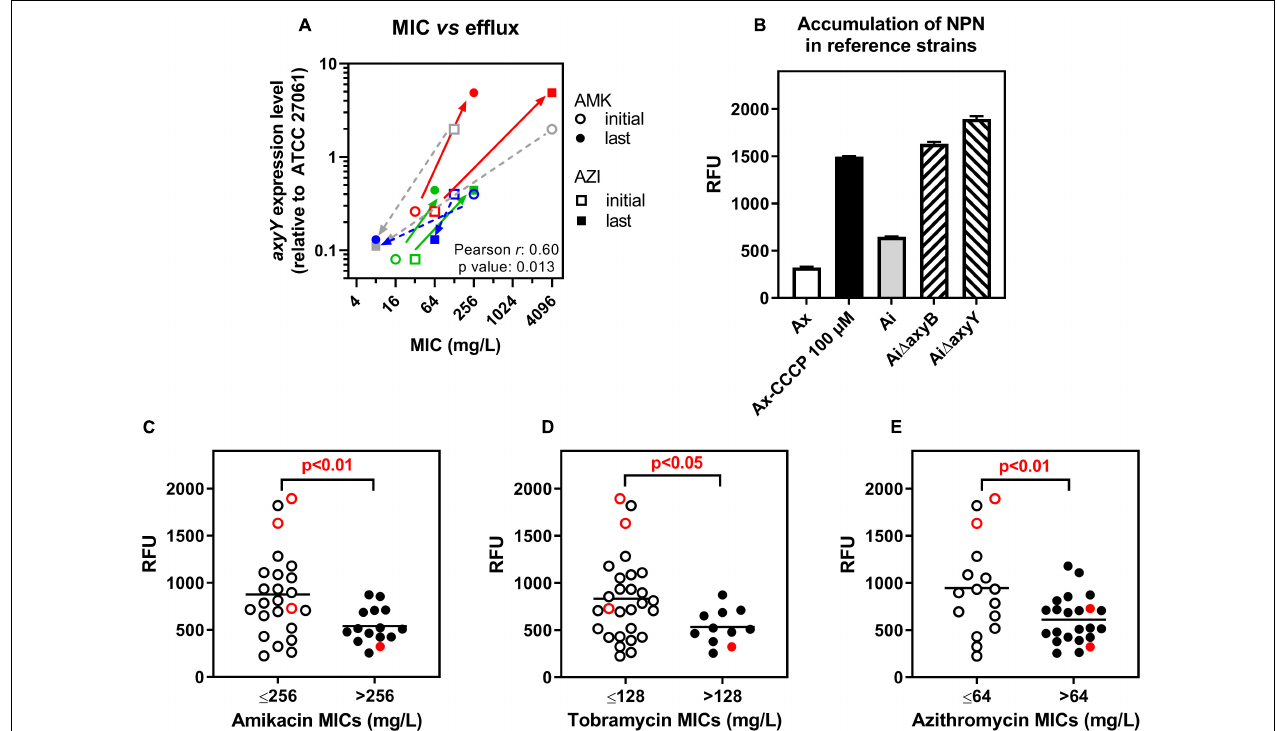
FIGURE 2 | Influence of active efflux on amikacin, tobramycin and azithromycin activity. (A) Correlation between the MIC of amikacin (AMK) or azithromycin (AZI) and the level of expression of axyY (relative to that in ATCC 27061) in 4 pairs of isolates, represented by different colors. Plain arrows joint data points of pairs for which the late isolate was more resistant [from patient 9 (red) and 10 (green)]; dotted arrows, those for which the late isolate was more susceptible [from patient 6 (gray) and 19 (dark blue)]. Pearson coefficient and p -values of the correlation are given. (B) Accumulation of the fluorophore NPN in reference strains (Ax: A. xylosoxidans ATCC 27061, Ai: A. insuavis ), mutants (Ai (cid:49) B: A. insuavis lacking axyB gene, Ai (cid:49) Y: A. insuavis lacking axyY gene), or in the presence of CCCP (100 µ M) used as a positive control in Ax to reduce the activity of efflux systems, after 10 min of incubation at 37 ◦ C. Data are means ± SD of three independent determinations and are expressed in arbitrary fluorescence units (standardized initial inoculum for all strains). (C–E) Accumulation of NPN in the same conditions in reference and clinical isolates stratified as a function of their MICs for amikacin, tobramycin, or azithromycin. Red open-closed symbols: reference strains; black open-closed symbols: clinical isolates. Statistical analysis: partition tree to determine the MIC value splitting the distribution in 2 with the highest Logworth (-log p -value) value ( p -value indicated on the graphs). The horizontal line corresponds to the mean